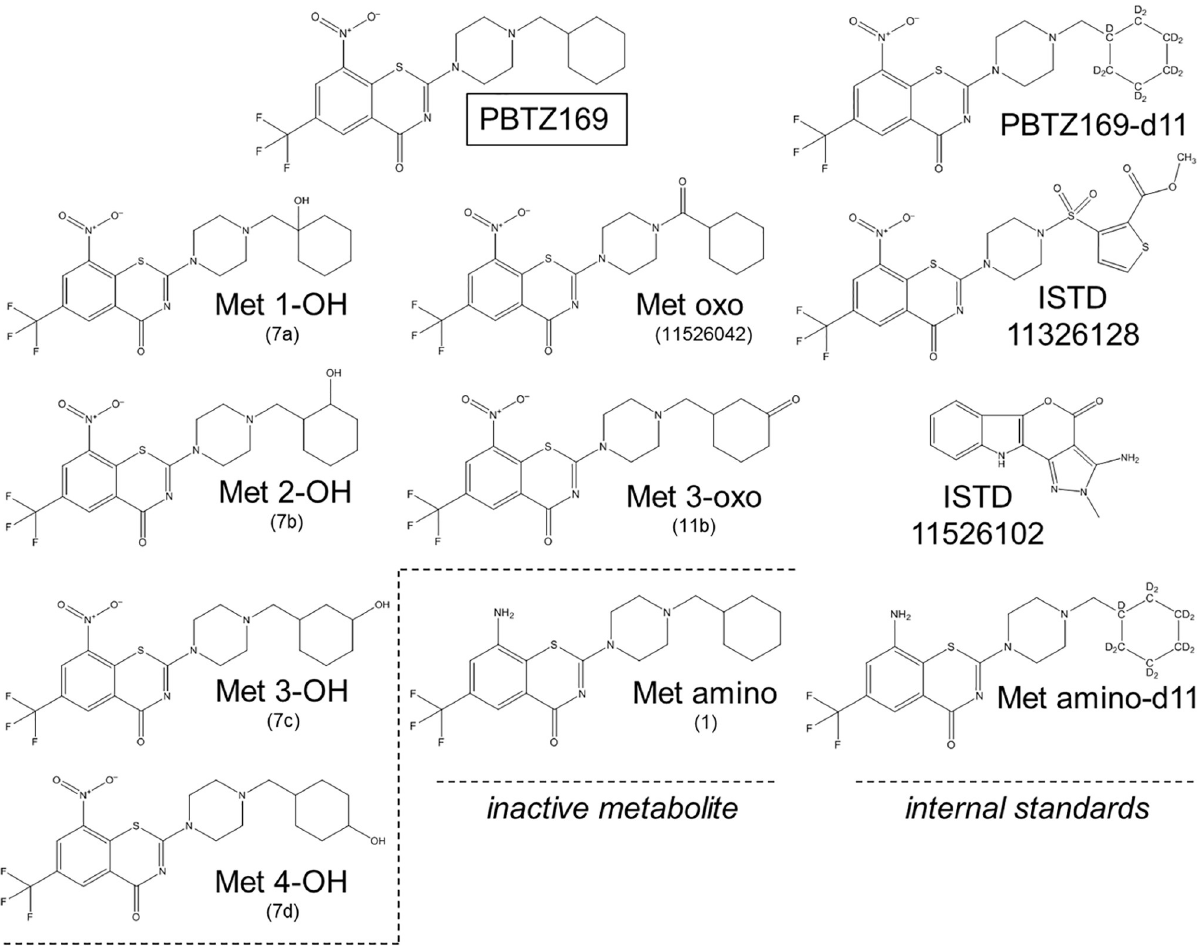
Fig 1. Chemical structures of PBTZ169, in vitro known metabolites and internal standards. In brackets, the names reported in the Investigator’s